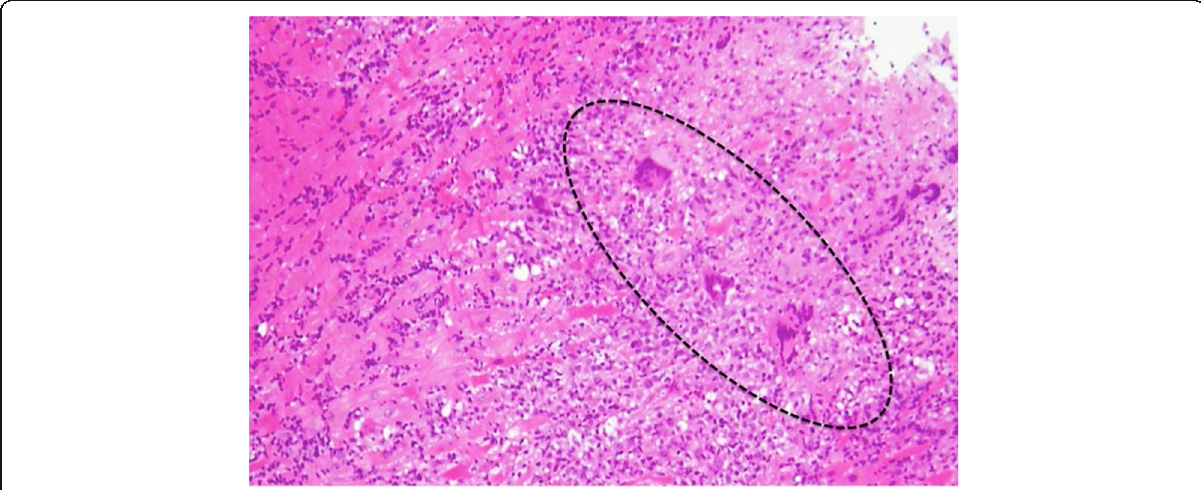
Fig. 2 Microscopic examination from the endomyocardial biopsy of the right ventricle. Characteristic infiltrations of multinucleated giant cells in the myocardium ( open circle ) were seen